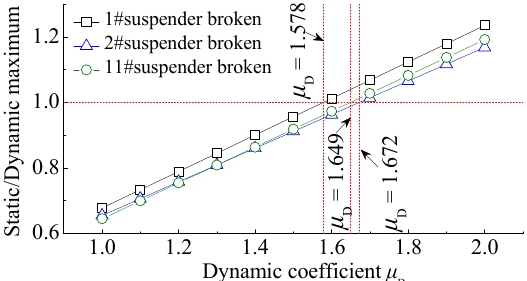
Figure 25. Comparison between suspender force by dynamic and static analysis.